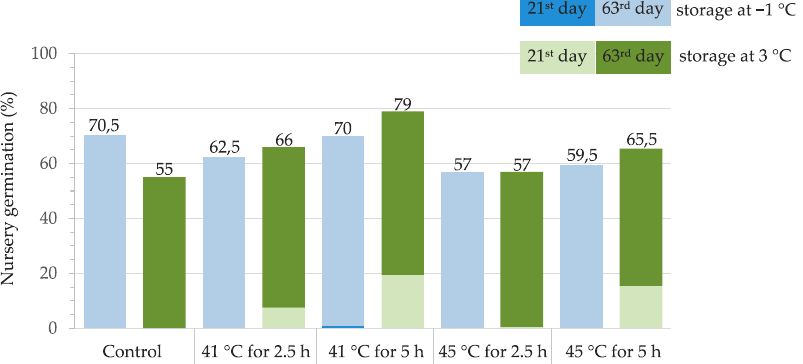
Figure 7. Nursery germination of thermotherapy treated and non-treated (control) acorns stored under different conditions, monitored 21 and 63 days after sowing.